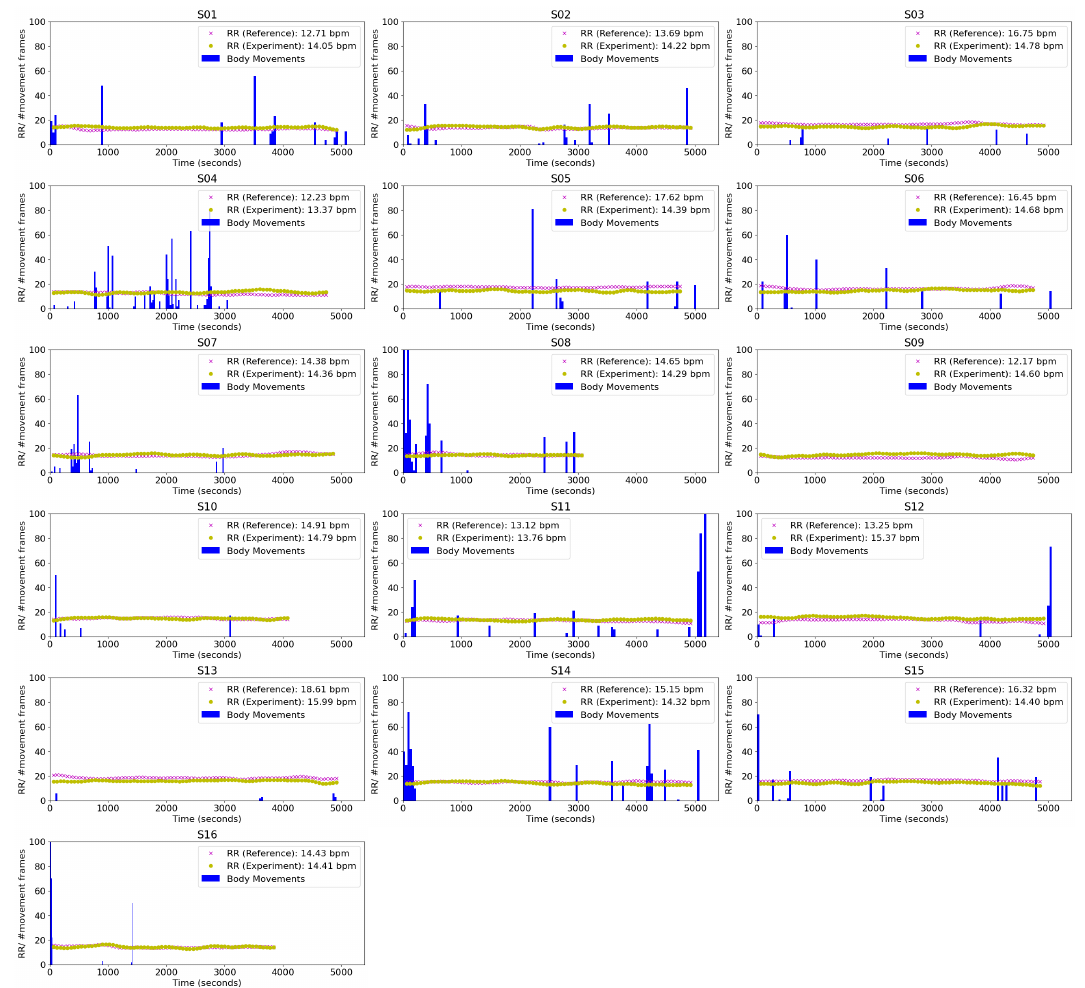
Figure 7. The result of the RMSE (respiratory rate) and body movements of